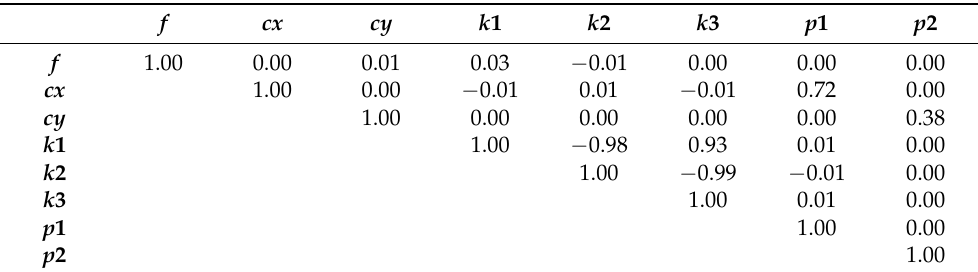
Table 5. Correlation coefficients of the parameters of interior orientation after calibration using the 3D calibration